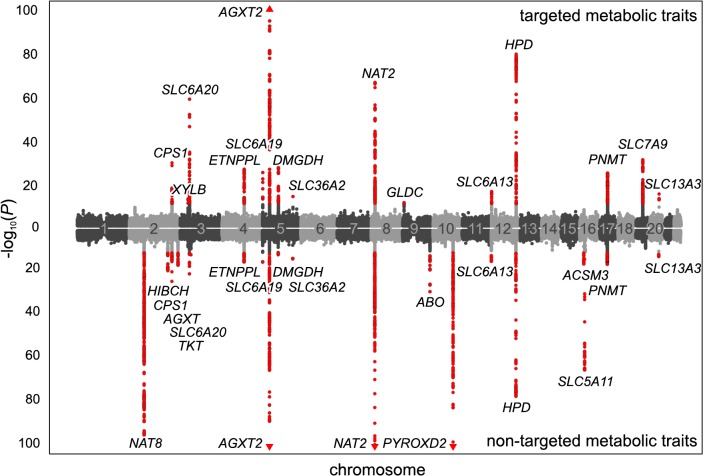
Manhattan plot of genetic associations to targeted and non-targeted traits.SNPs are plotted according to chromosomal location and the-log10 transformed P-value of the strongest association with targeted traits (top) and non-targeted traits (bottom). In case of associations with ratios, only associations with P-gain exceeding 15,180 (targeted metabolic traits) or 138,610 (non-targeted traits) were considered. Associations of genome-wide significance (P < 3.25×10−12) are plotted in red. Triangles indicate associations with P < 1.0×10−100. Significant associations within a physical distance of 1 Mb were assigned to a locus labeled after the most likely causative gene (as determined using an evidence-based approach for the identification of candidate genes; see Methods).